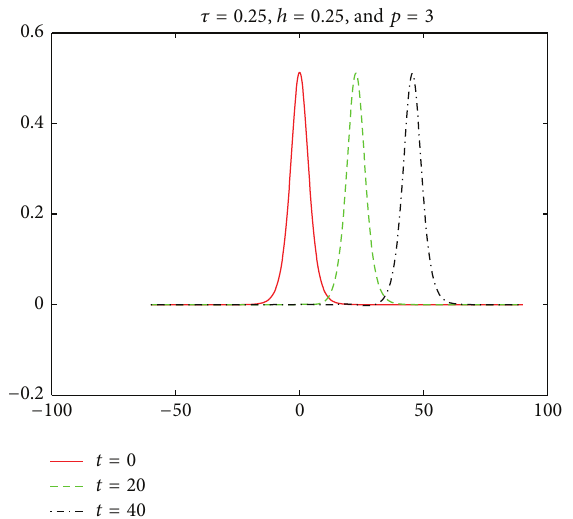
Figure 3: Wave graph of 𝑢(𝑥,𝑡) at various times when 𝑝 = 5 and 𝜏 = ℎ = 0.25 .